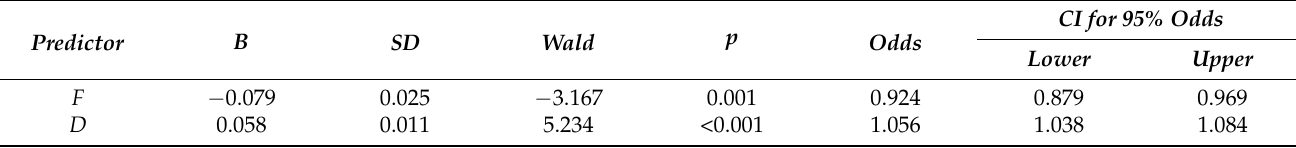
Table 4. Depersonalization (DP) ˆ L s ( F , D ) = ˆ B 0 + ˆ B F F + ˆ B D D ; s = 1,2.